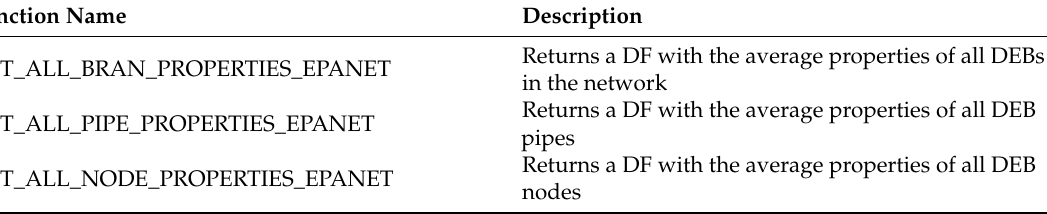
Table 7. Description of Get All Properties